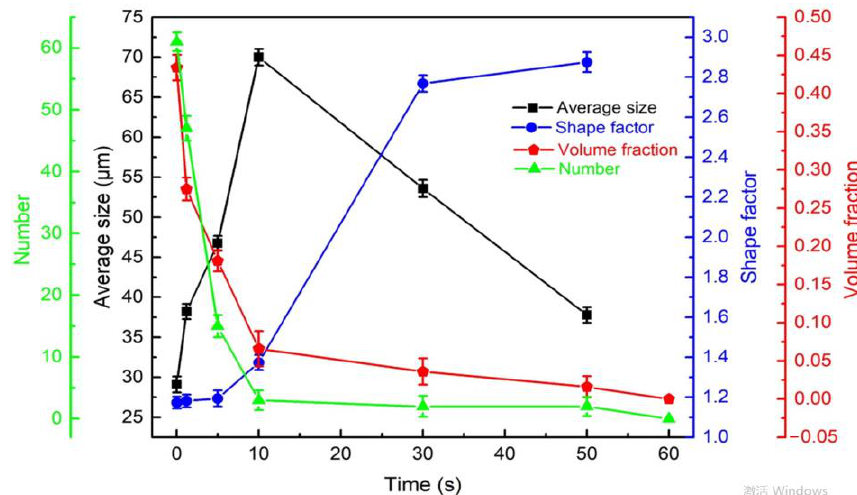
Figure 13. Variations in average size, shape factor, number and fractions of nondendritic primary Al grains due to standing time.